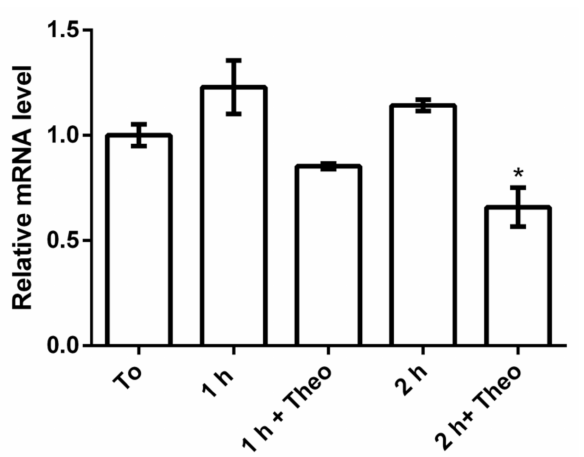
Figure 5. Effect of theophylline on the expression of parB . The mutant strain X. citri parB :: rbsw was cultivated from the starting OD600nm of ~0.1 for a total period of 4 h (T0). Theophylline was added to a final concentration of 2 mM, and the parB mRNA was monitored by qRT-PCR. T0: parB mRNA expression level after 4 h of bacterial growth; 1 h: untreated after 5 h of growth; 1 h + theo: 1 h of growth under exposure to 2 mM theophylline, total growth of 5 h; 2 h: untreated after 6 h of growth, and 2 h + theo: 2 h of growth under exposure to 2 mM theophylline, total growth of 6 h. * indicates significant difference according to ANOVA